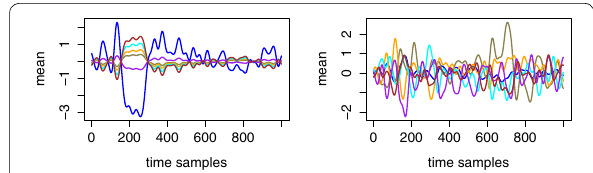
Fig. 6 Reconstructed signal based on average PCA, corresponding to User 8, Electrode P7, using the first dimension (left) and all the other dimensions